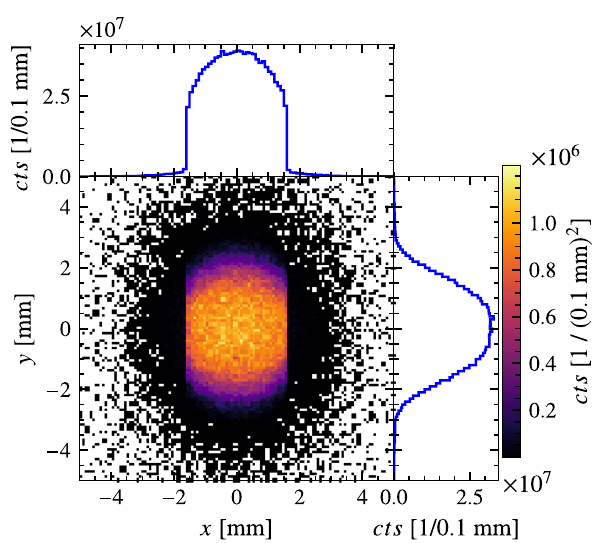
Fig. 6 Distributions of energy-weighted energy depositions of the alphas reaching the detector as predicted by GEANT4 for monoen- ergetic 5.485MeV alphas from the source volume directed downwards with an opening angle of 3 degrees. The y-axis is parallel to the radial directioninthe cylindrical coordinate system of the detector, see Fig.